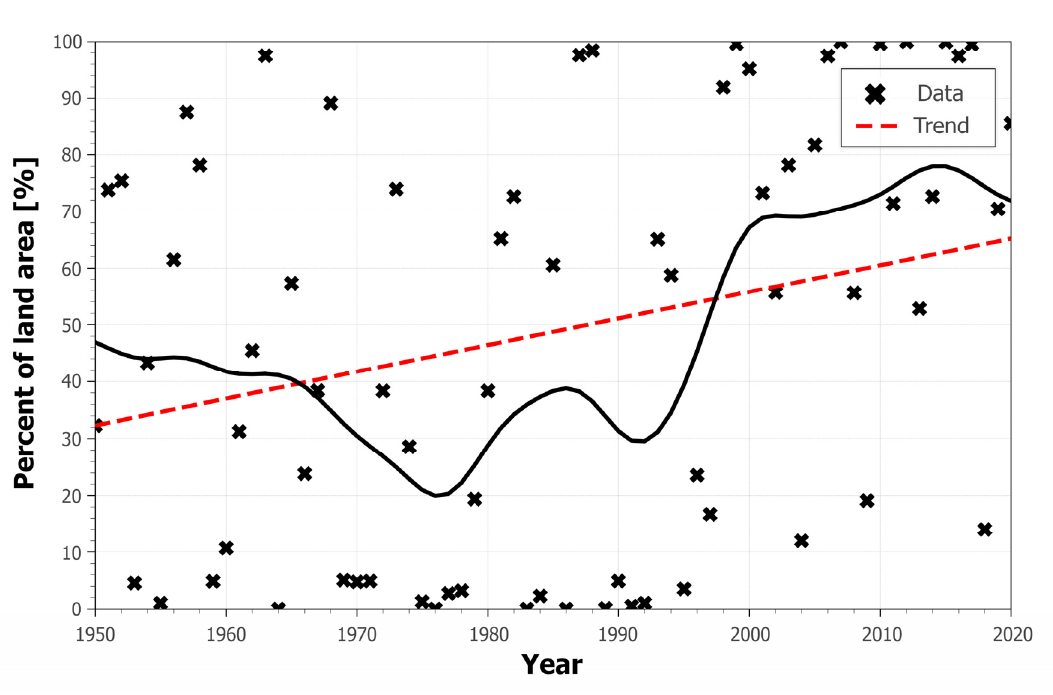
Figure 10. The annual values of the percent of land area of Greece that experiences at least one heatwave per year (black star) calculated from ERA5-Land during the period 1950–2020, plotted together with a 9-year Gaussian low-pass filter (black thick line) and trend line calculated at the 95% significant level (red line).